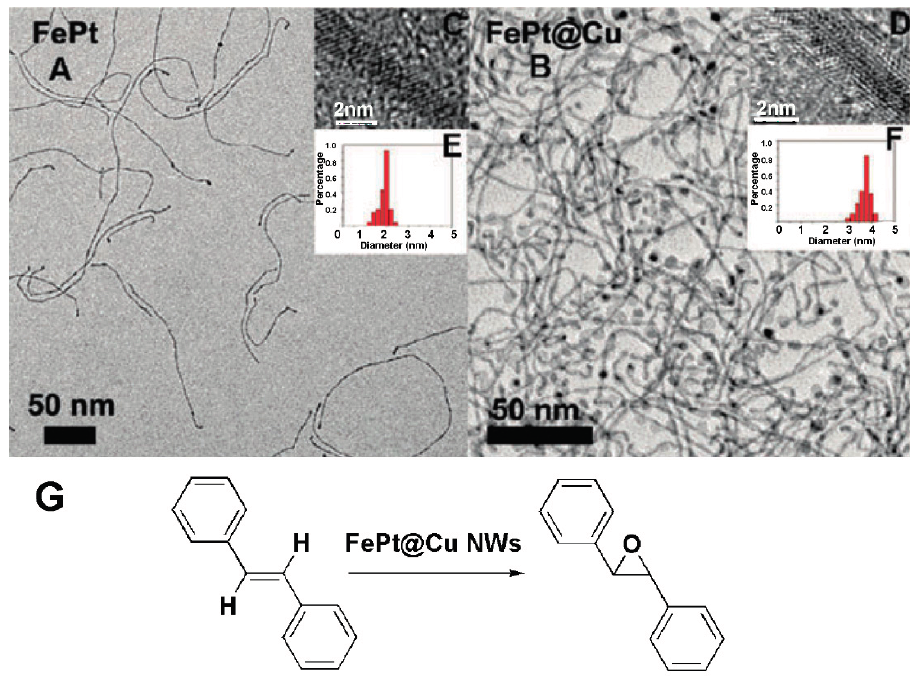
Figure 1. ( A ) The TEM and ( C ) high resolution TEM images of FePt nanowires (NWs); ( B ) The TEM and ( D ) high-resolution TEM images of FePt@Cu NWs; ( E ) The histograms of the diameters of FePt NWs and ( F ) FePt@Cu NWs; ( G ) The epoxidation of trans -stilbene using FePt@Cu NWs as catalysts